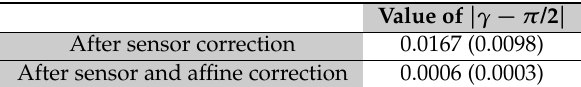
Table 2. Mean and standard deviation of | γ − π /2 | (in radians) on 10 grid images with different rotations before and after applying affine correction of Equation (8), where γ is the angle between a “horizontal” and a “vertical” line. It can be seen that the difference between γ and π /2 is strongly reduced (i.e., γ close to π /2) after the affine correction and is lower than the angular resolution (1.2 × 10 − 3 rad). Value of | γ − π /2 | After sensor correction 0.0167 (0.0098) After sensor and affine correction 0.0006